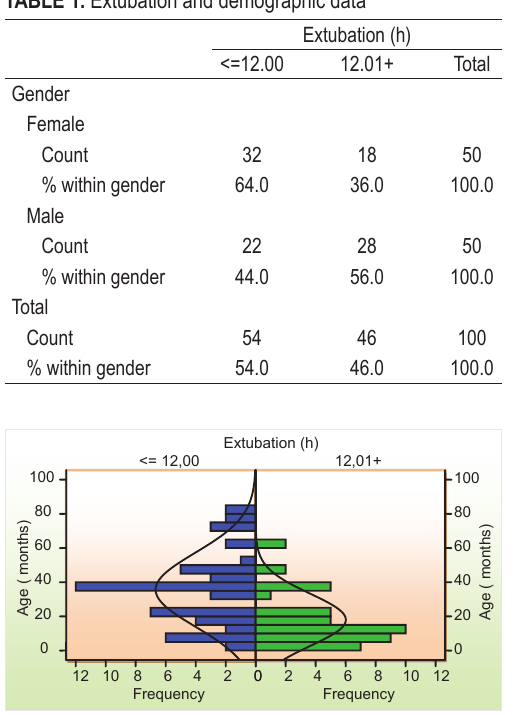
FIGURE 1. Histogram frequency age of the patients and time of the extubation.